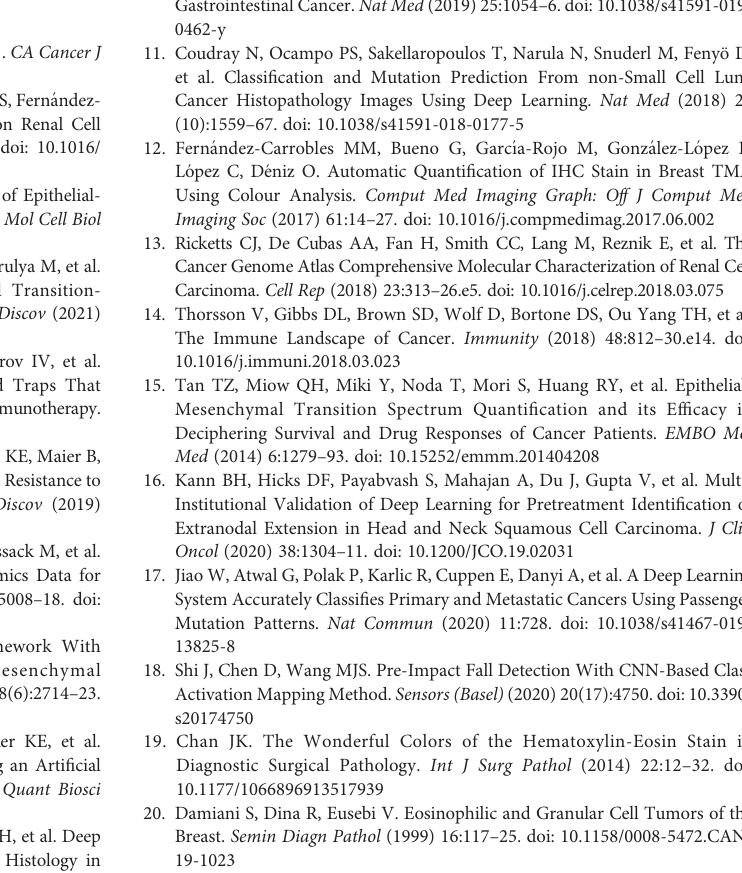
Supplementary Figure 1 | Kaplan-Meier plots of OS of the cohort. Supplementary Figure 2 | GSEA plot of cytokine recceptor interaction, JAK- STAT pathway, chemokine signaling pathway, regulation of alpha beta T cell activation and differentiation in Mes cluster. Supplementary Figure 3 | Kaplan-Meier plots of OS of the different expression levels of immune checkpoint